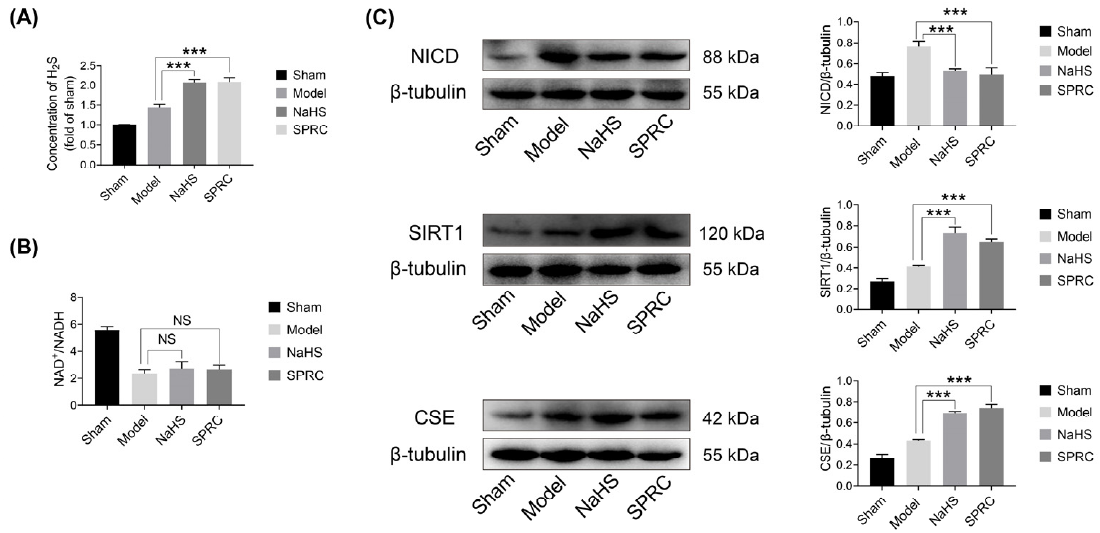
Figure 5. H 2 S level, NAD + /NADH ratio, CSE, SIRT1 and NICD protein expressions assessments in injured nerves of rats at 2 weeks after surgery for each group. ( A ) Statistical analysis of H 2 S level. ( B ) Statistical analysis of NAD + /NADH ratio. ( C ) WB analyses of CSE, NICD and SIRT1 protein expressions. Relative grey values analyses were performed. β -tubulin was used as a loading control. Data were presented as mean ± SEM ( n = 5 rats). *** p < 0.001 vs. model group, NS, no significant.